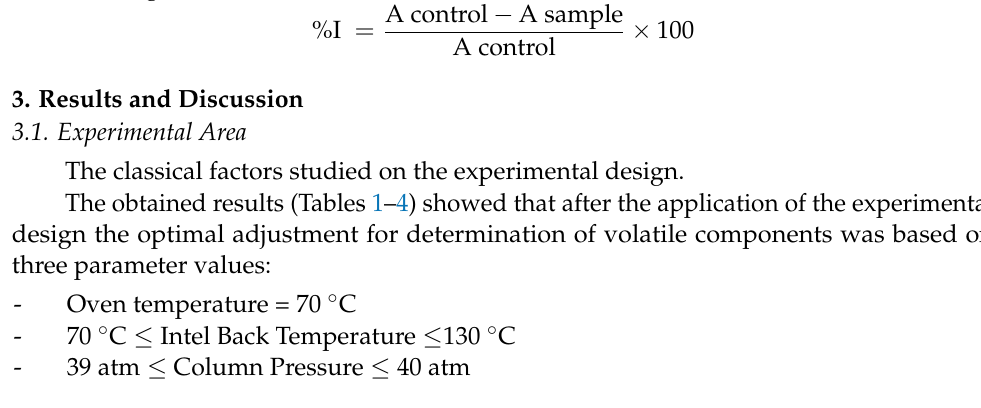
Table 1. The factors influenced on the retention time of diacetyl analyzed by experimental design. Experience Factors Centre Variation Degree X1 Oven temperature. 100 ◦ C 30 X2 Intel Back Temperature. 100 ◦ C 30 X3 Pressure Column. 39.5